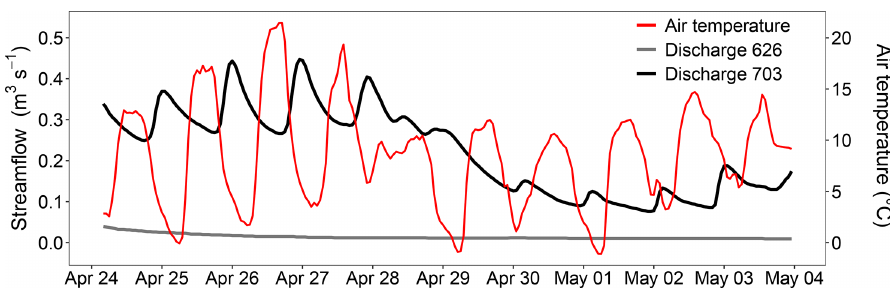
Figure A3. Discharge and air temperature at watershed 703 during 10d without rainfall in the snowmelt season (measured at SSN703 and WSN703, respectively). Daily fluctuations in 703’s streamflow indicate snowmelt contributions. Peak flows occur ∼ 12h after the daily maximum air temperatures. Discharge at watershed 626 (low elevation watershed with no snowpack) is shown for reference. The stable recession indicates no rainfall inputs during this period.